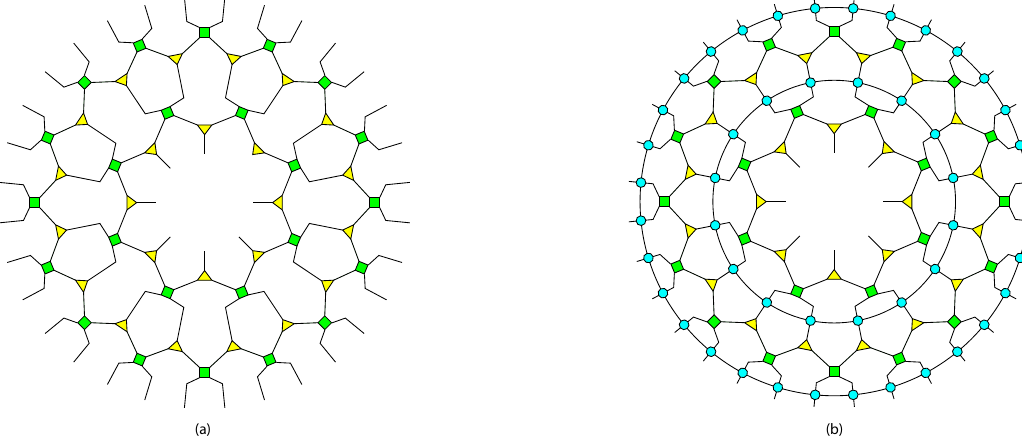
Figure 12 . (a) The traditional MERA tensor network on the circle, made of disentanglers u (the green squares) and coarse-grainers w (the yellow triangles). (b) The Euclidean MERA tensor network on the circle, made of disentanglers u (the green squares) and coarse-grainers w (the yellow triangles), and eclideons e (the blue solid